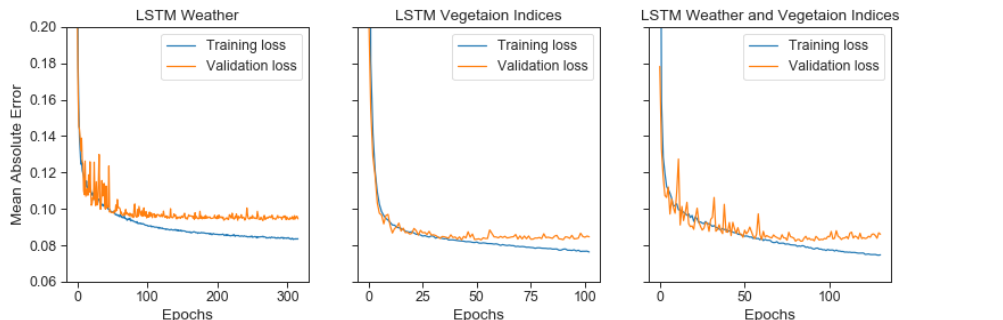
Figure 12. Training and validation loss for the LSTM model.